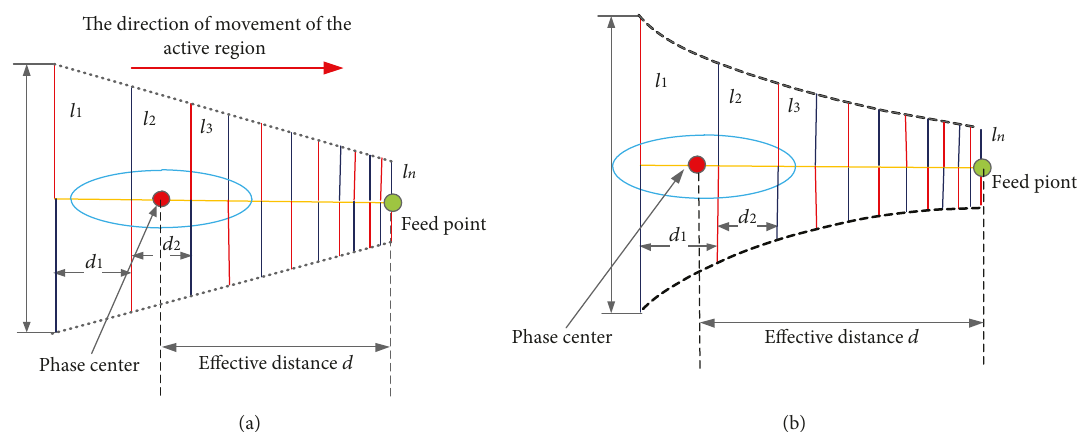
Figure 1: The schematic diagram of the e ff ective distance d of LPDA: (a) the traditional LPDA and (b) the proposed